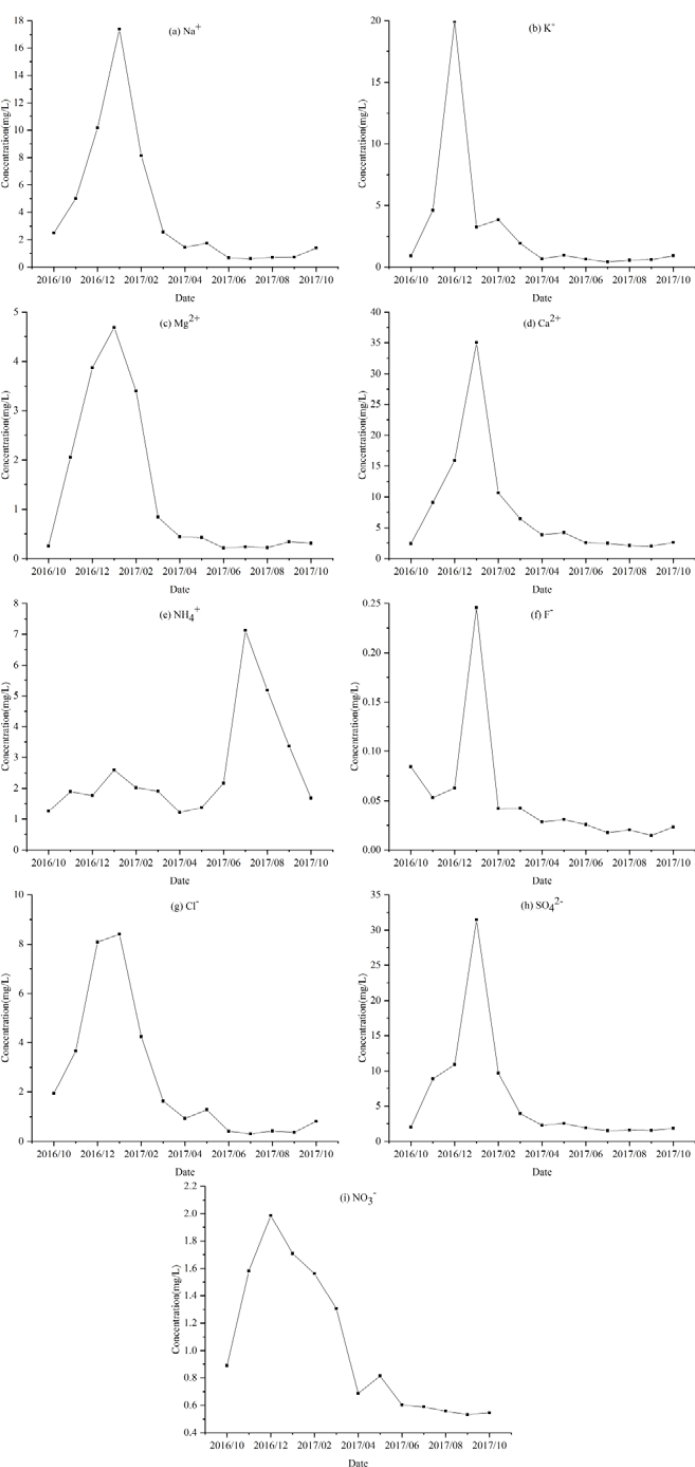
Figure 7. Seasonal variation of ion concentration in the study area (calculate the volume-weighted average monthly).